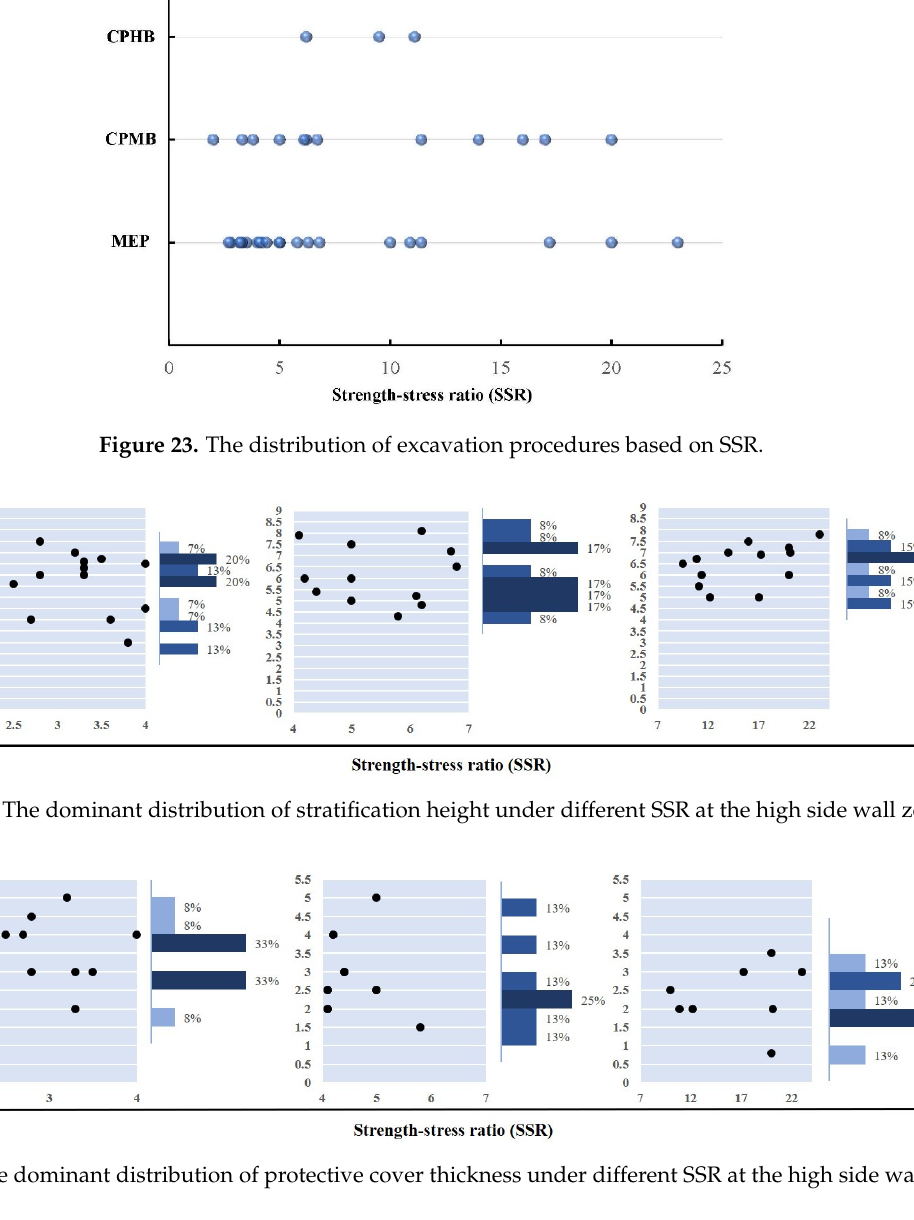
Table 4. Recommendations for excavation procedure design based on SSR (m).